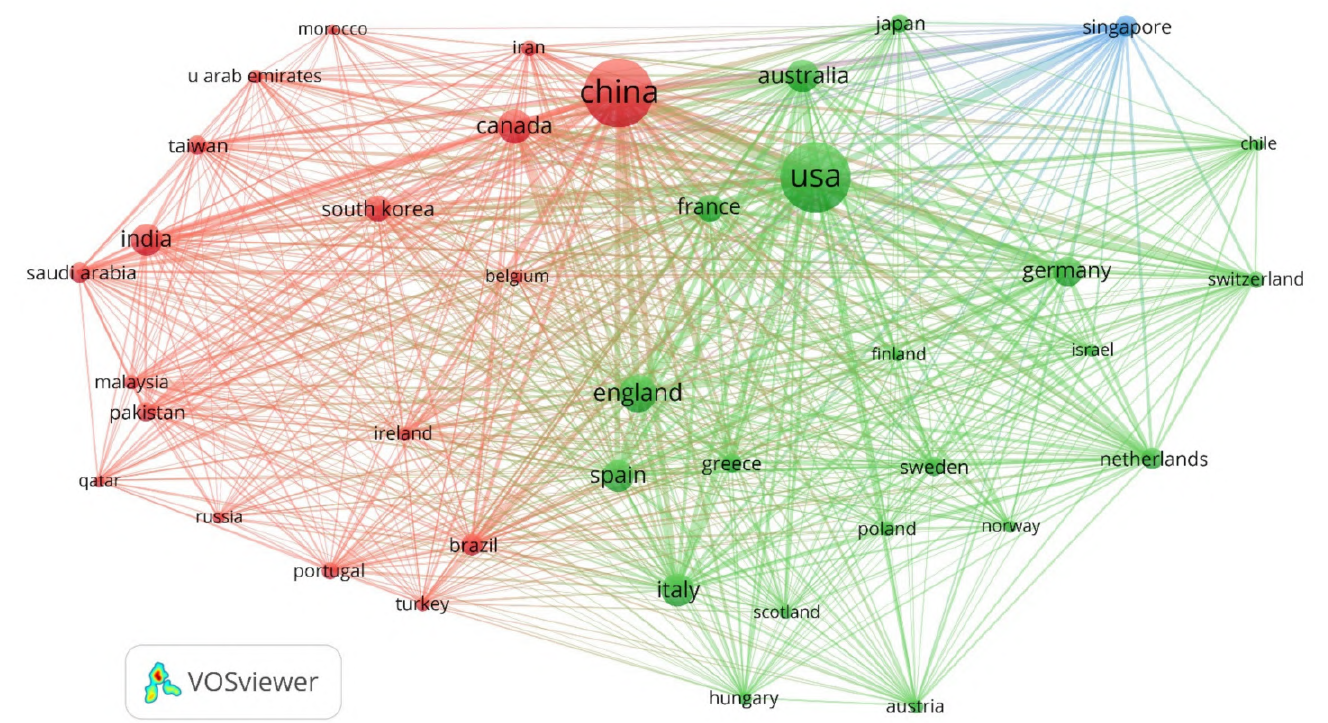
Figure 6. Countries with the most contributions. Illustration by